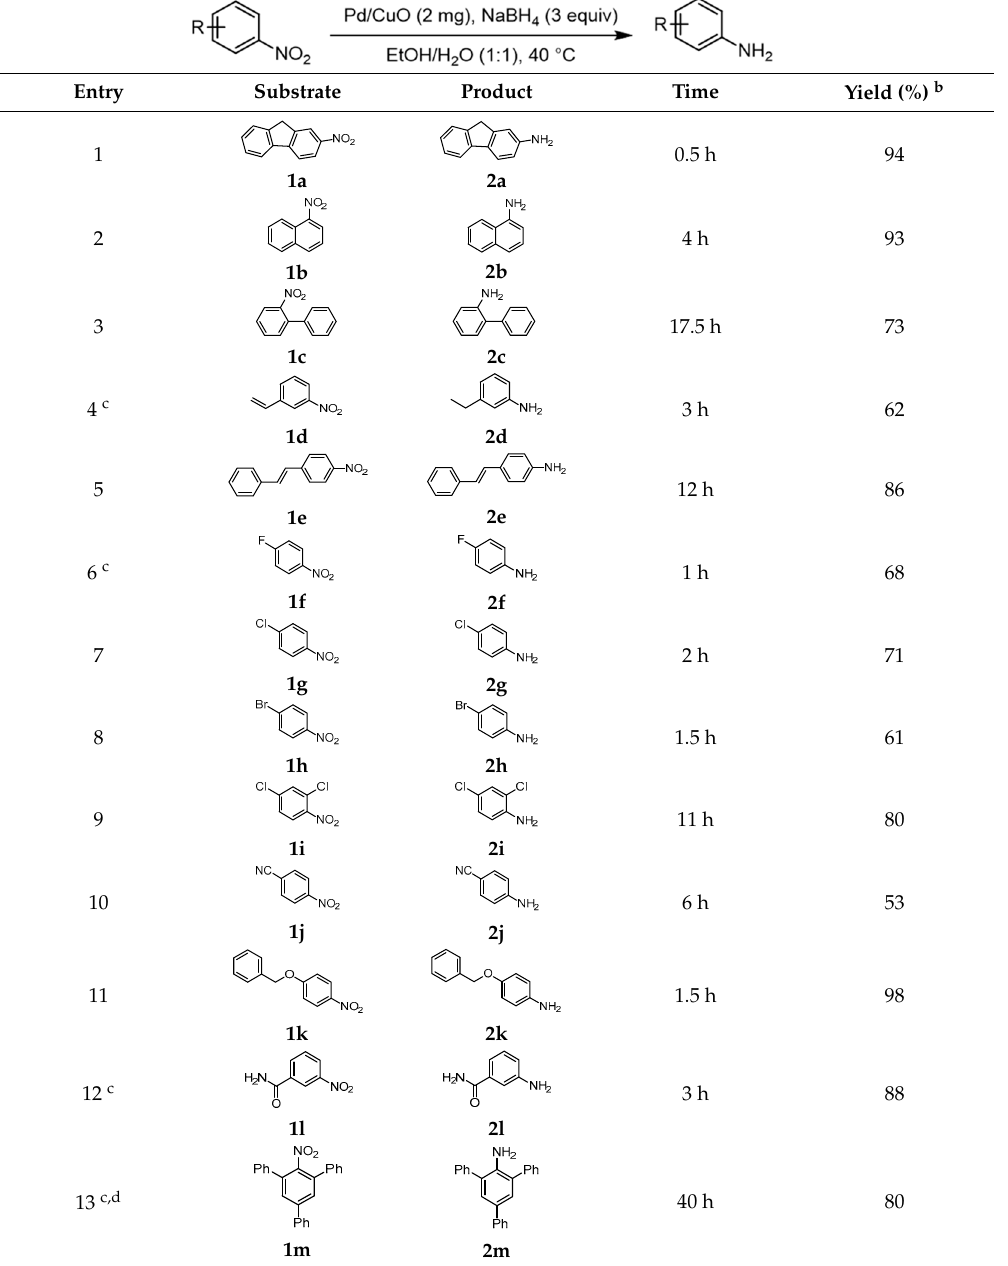
Table 2. Evaluation of the scope of the nitroarene reduction a .